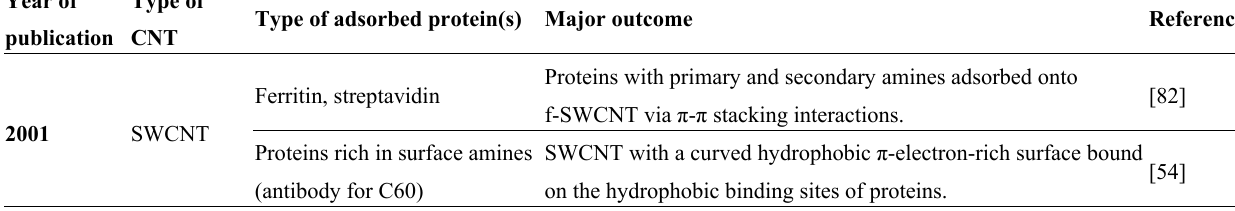
Table 2. Key literature (for the past two decades) concerning the carbon nanotubes (CNT)-protein interaction. Please note that this table is not a complete list, however highlights the key papers regarding CNT-biomolecule